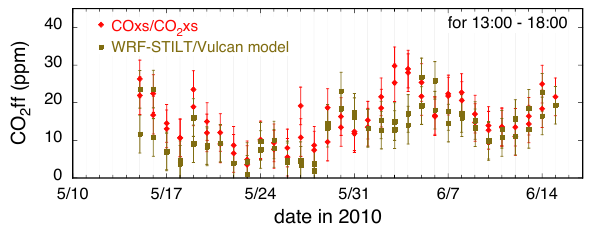
Fig. B2. Comparison of time series for CO 2 ff determined using COxs/CO 2 xs and constant R of 0.011 with that predicted using WRF-STILT and Vulcan 2.0 emissions, for 13:00–18:00, during the CalNex-LA campaign. For each day, average values are plotted for 13:00–15:00 and 16:00–18:00 for CO 2 ff from both measurements and prediction. Error bars are ± 5 ppm, based on requiring that re- duced χ 2 = 1 during the linear regression calculation.